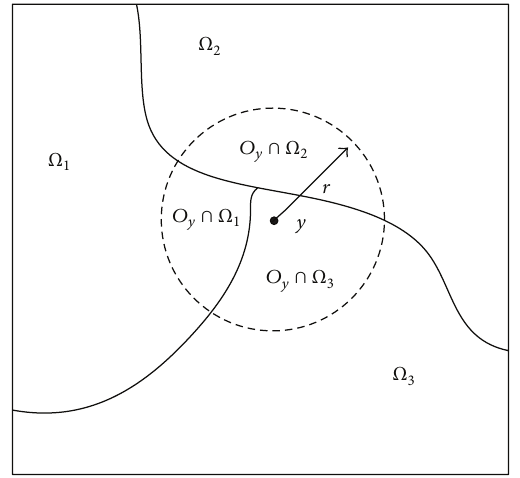
Figure 1: Graphical representation of 𝑂 𝑦 ∩ Ω 𝑖 . The dashed circle denotes the circular neighborhood 𝑂 𝑦 centered on 𝑦 . The image domain Ω is divided into three disjoint regions Ω 1 , Ω 2 , and Ω 3 , which partition the neighborhood 𝑂 𝑦 into three subregions 𝑂 𝑦 ∩Ω 1 , ∩ Ω 𝑂 ∩ Ω 𝑂 𝑦 2 , and 𝑦 3